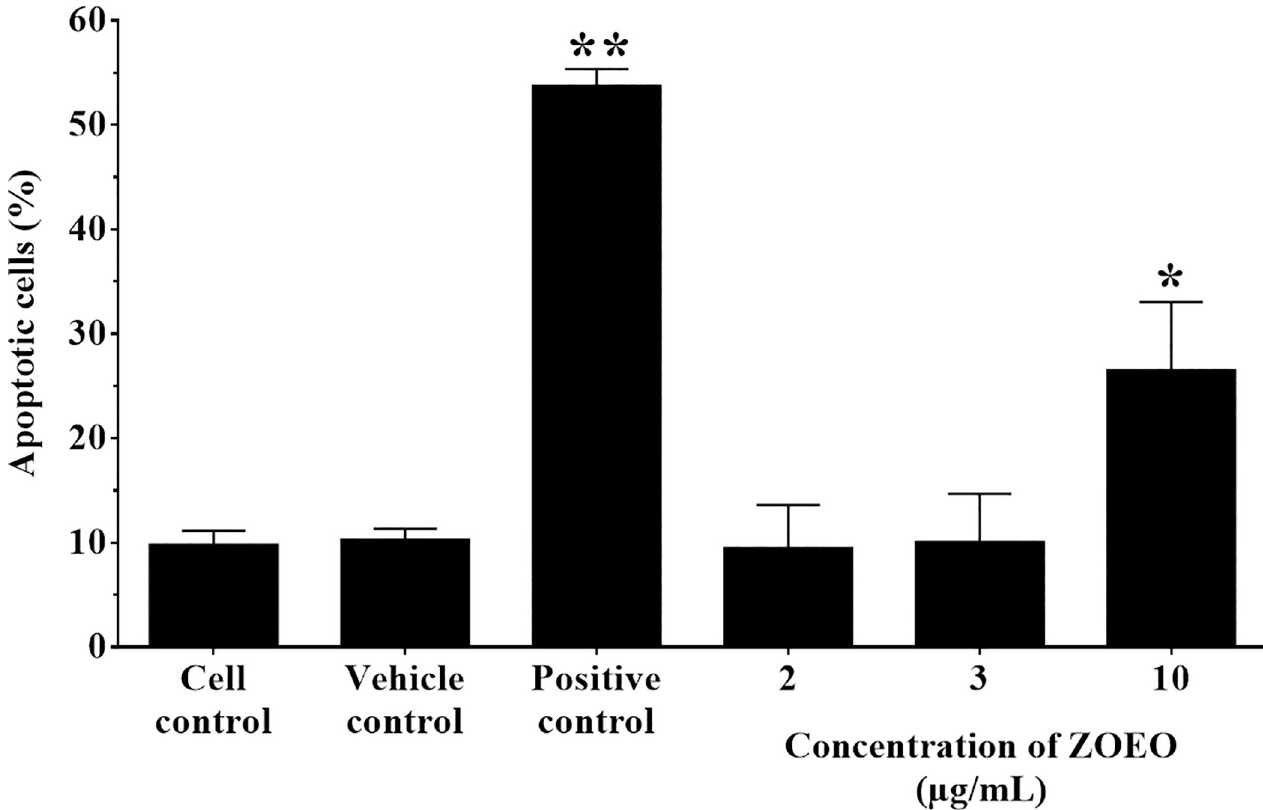
Fig 6. Representative bar graph of apoptotic cells (%) by flow cytometer after ZOEO treatments in various concentrations. MCF-7 cells were treated with ZOEO at the concentrations of 2, 3, and 10 μ g/mL and stained with double annexin V-FITC/propidium iodide (PI). The percentage of apoptotic cells was statistically compared. Each bar represents mean ± SD of three independent experiments performed in triplicate. Asterisk ( � ) denotes significant differences from vehicle control; � p < 0.05, �� p < 0.001. The dataset is available in S7 Table.